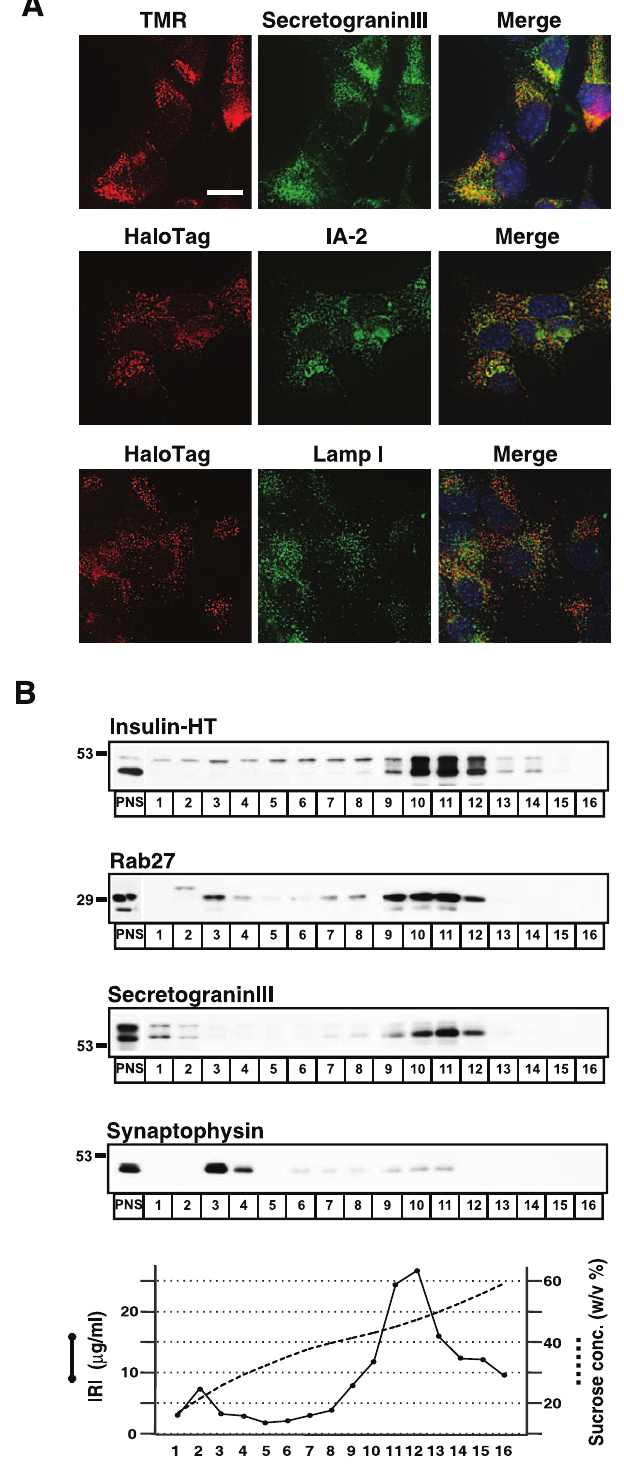
Figure 1. Insulin-HT targets to secretory granules in MIN6 cells. A, MIN6 cells stably expressing insulin-HT (clone # 67) were incubated with 5 m M HT-TMR probe for 30 minutes. The cells were then fixed and stained with anti-secretogranin III and Alexa488-conjugated anti-rabbit IgG antibodies (top panels). The stable cells were double-immuno- stained with anti-HaloTag and anti-IA-2 antibodies (middle panels) or anti-HaloTag and anti-lamp I antibodies (bottom panels). DAPI